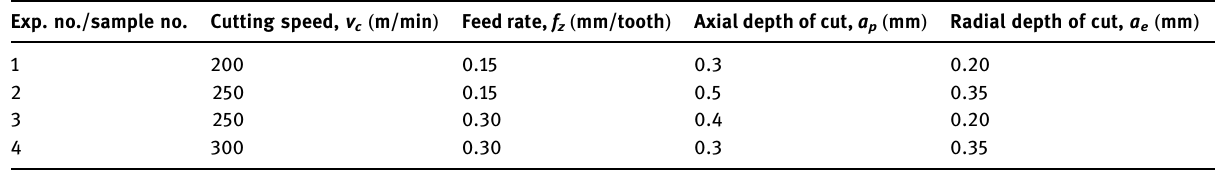
Table 2: Experimental conditions for the machining test